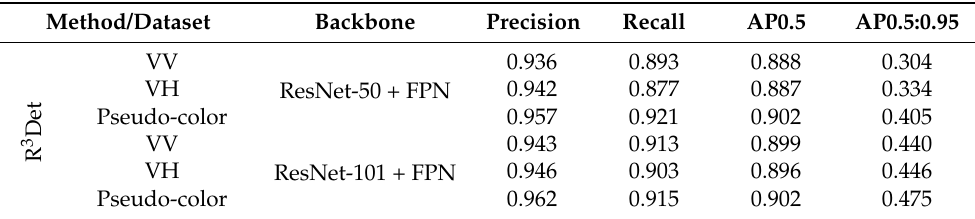
Table 2. R 3 Det detection results on pseudo-color enhanced and corresponding VV and VH polarized test set of DSSDD.